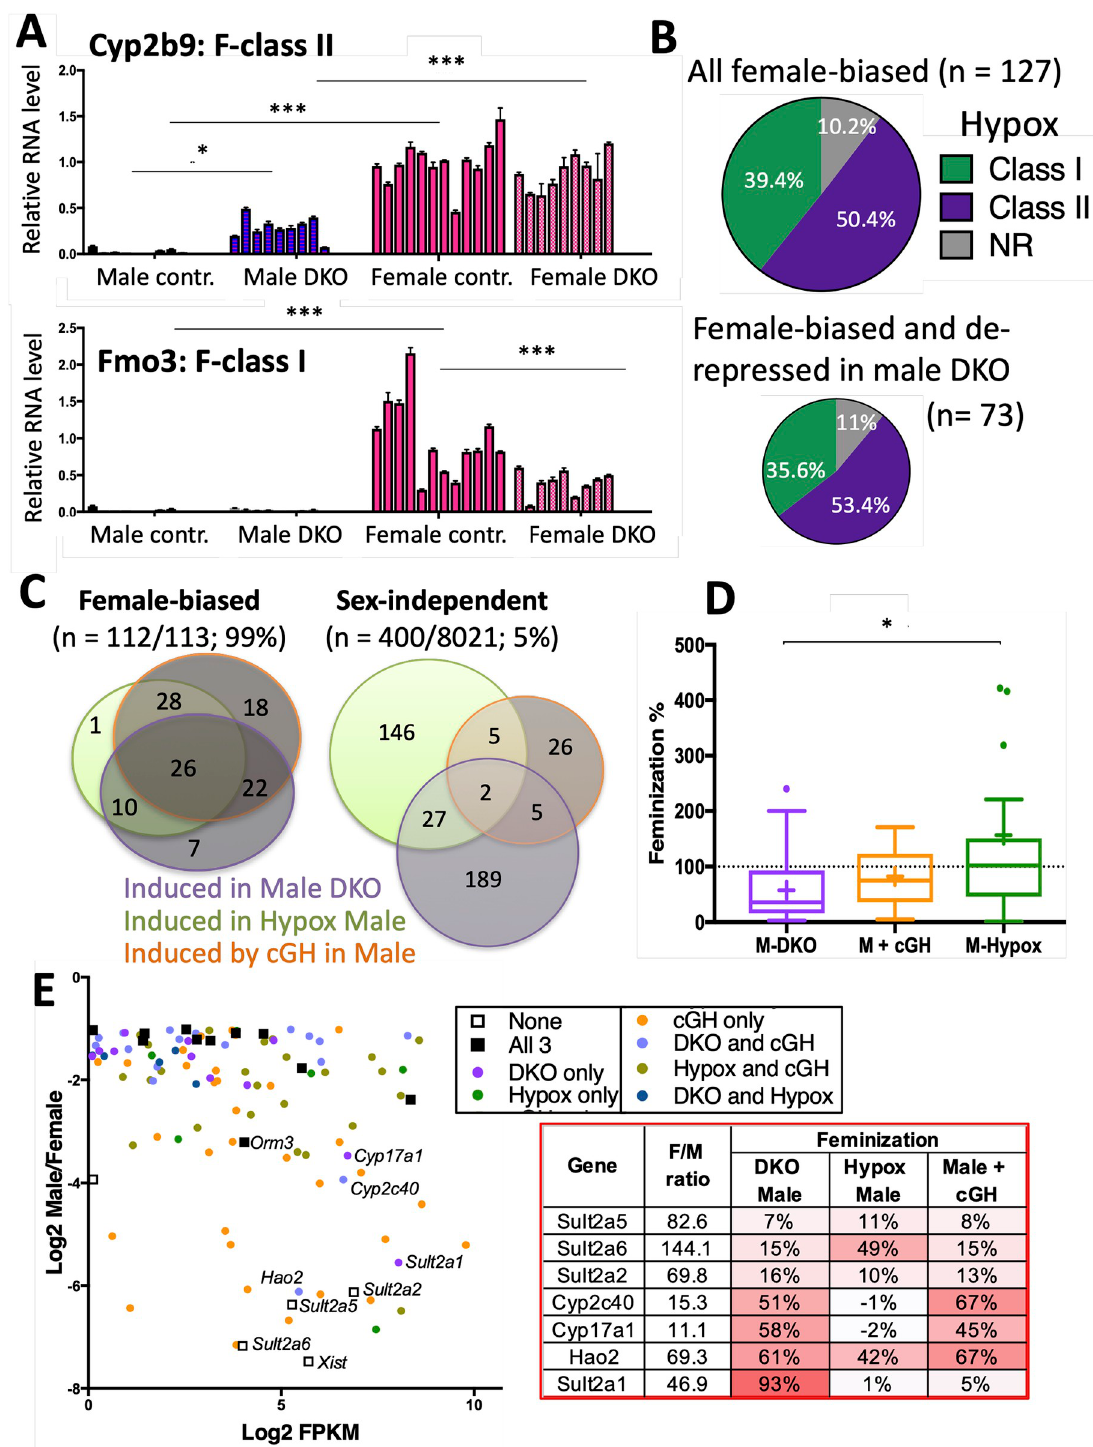
Fig 3. Loss of Ezh1 and Ezh2 partially feminizes the expression of GH-responsive genes. ( A ) Expression of Fmo3 , a female-biased class-I hypophysectomy (Hypox)-responsive gene (i.e., gene is down-regulated in female liver after Hypox), and Cyp2b9 , a female-biased class-II Hypox-responsive gene (i.e., gene is up-regulated in male liver after Hypox), in total RNA isolated from floxed control and E1/ E2-KO male and female mouse liver. Data shown are mean +/- SD values determined by RT-qPCR for n = 9–12 individual livers per group. The mean expression value for the control (wild-type) female group was set to 1. Significance values by ANOVA are shown: � , p <